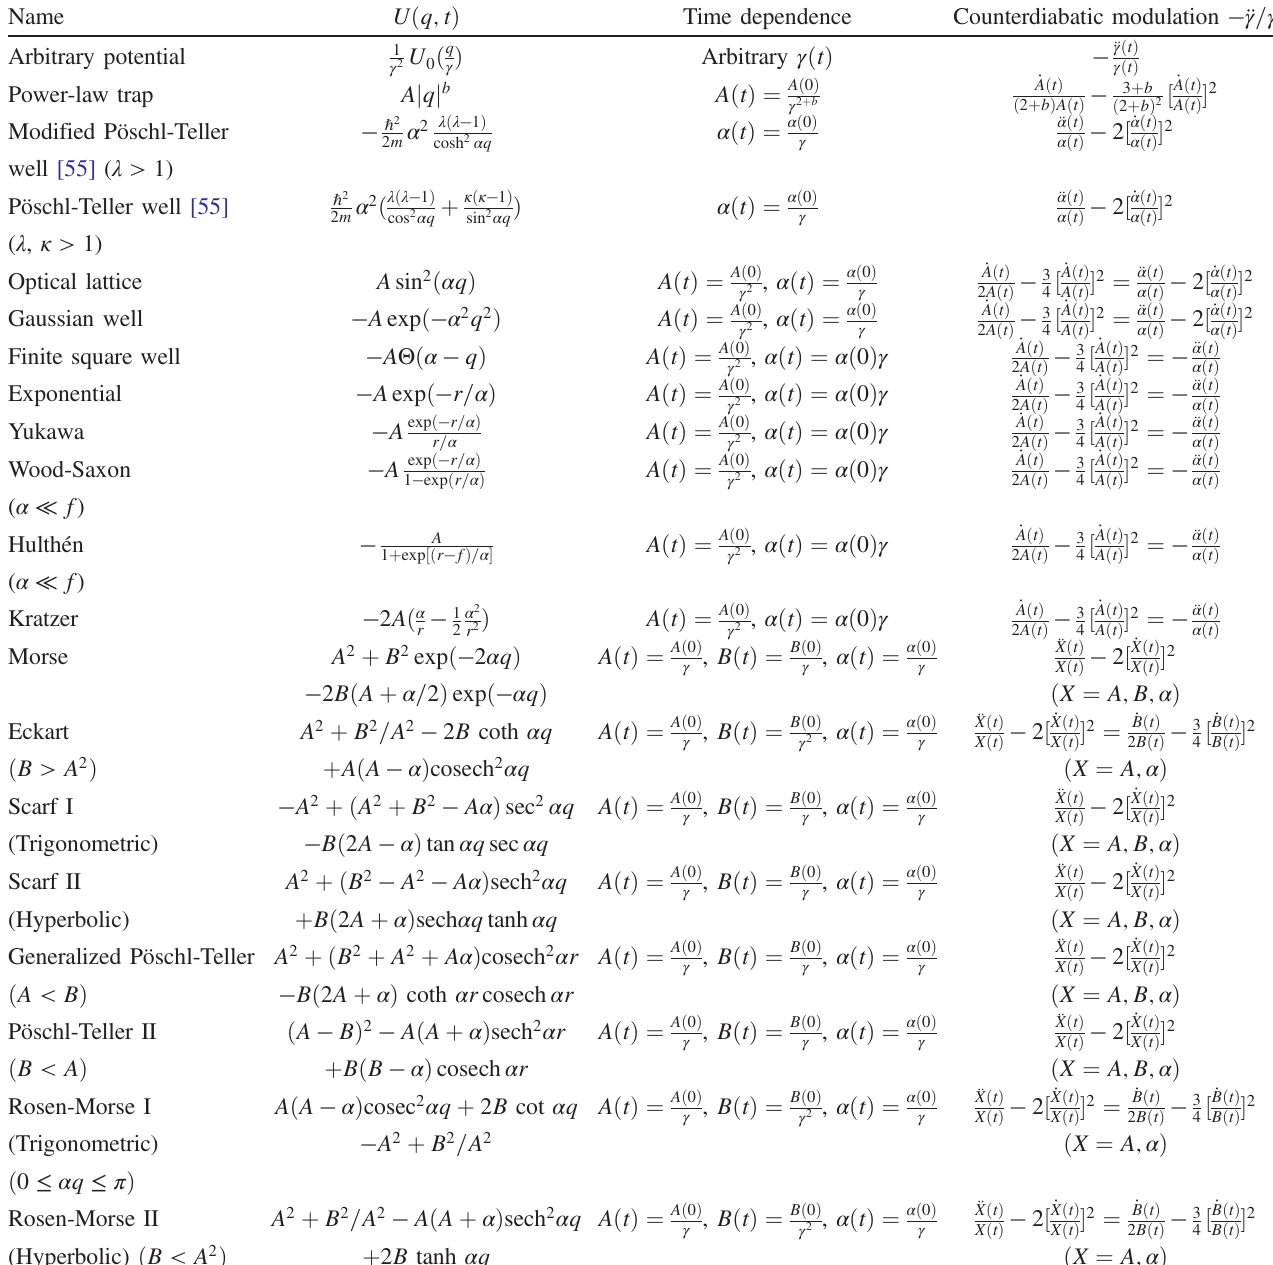
TABLE I. List of counterdiabatic driving schemes for potentials that acquire the form of U ð q; t Þ in Eq. (3) under the indicated time dependence of the parameters A , B , and α , including well-known shape-invariant potentials in supersymmetric quantum mechanics. A ¯ U local CD protocol for expansions and compressions ( f ¼ 0 ) is induced by the potential ð ¯ q; t Þ ¼ U ð ¯ q; t Þ − m ̈ γ ¯ q 2 = ð 2 γ Þ . When meaningful, the same potentials can be used as a two-body potential V with α ¼ 2 . A single degree of freedom is considered for clarity; the extension to higher dimensions under cylindrical or spherical symmetry is straightforward following Ref. [16]. The range of potentials is − ∞ ≤ q ≤ ∞ , 0 ≤ r ≤ ∞ , unless stated otherwise. The family of power-law potentials [28,33] includes the harmonic case ( b ¼ 2 ) [15] and the infinite square well ( b ¼ ∞ )